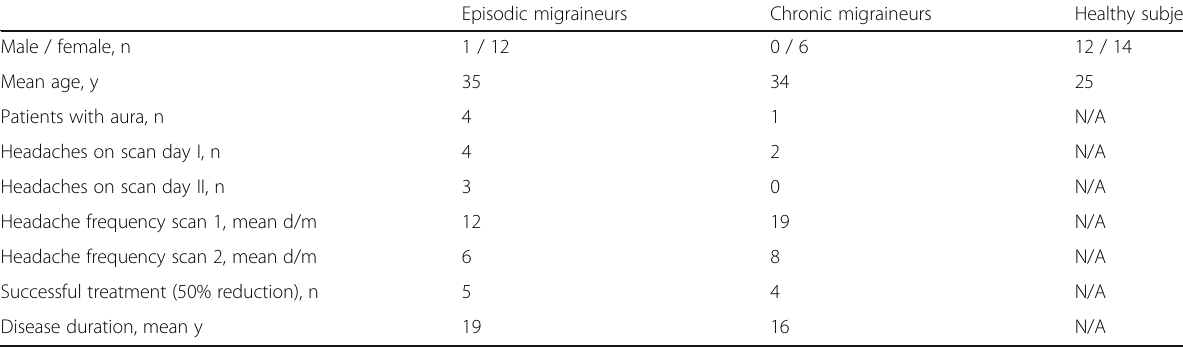
Table 1 Clinical characteristics of the patients population ( n = 19) Episodic migraineurs Chronic migraineurs Healthy subjects Male / female, n 1 / 12 0 / 6 12 / 14 Mean age, y 35 Patients with aura,